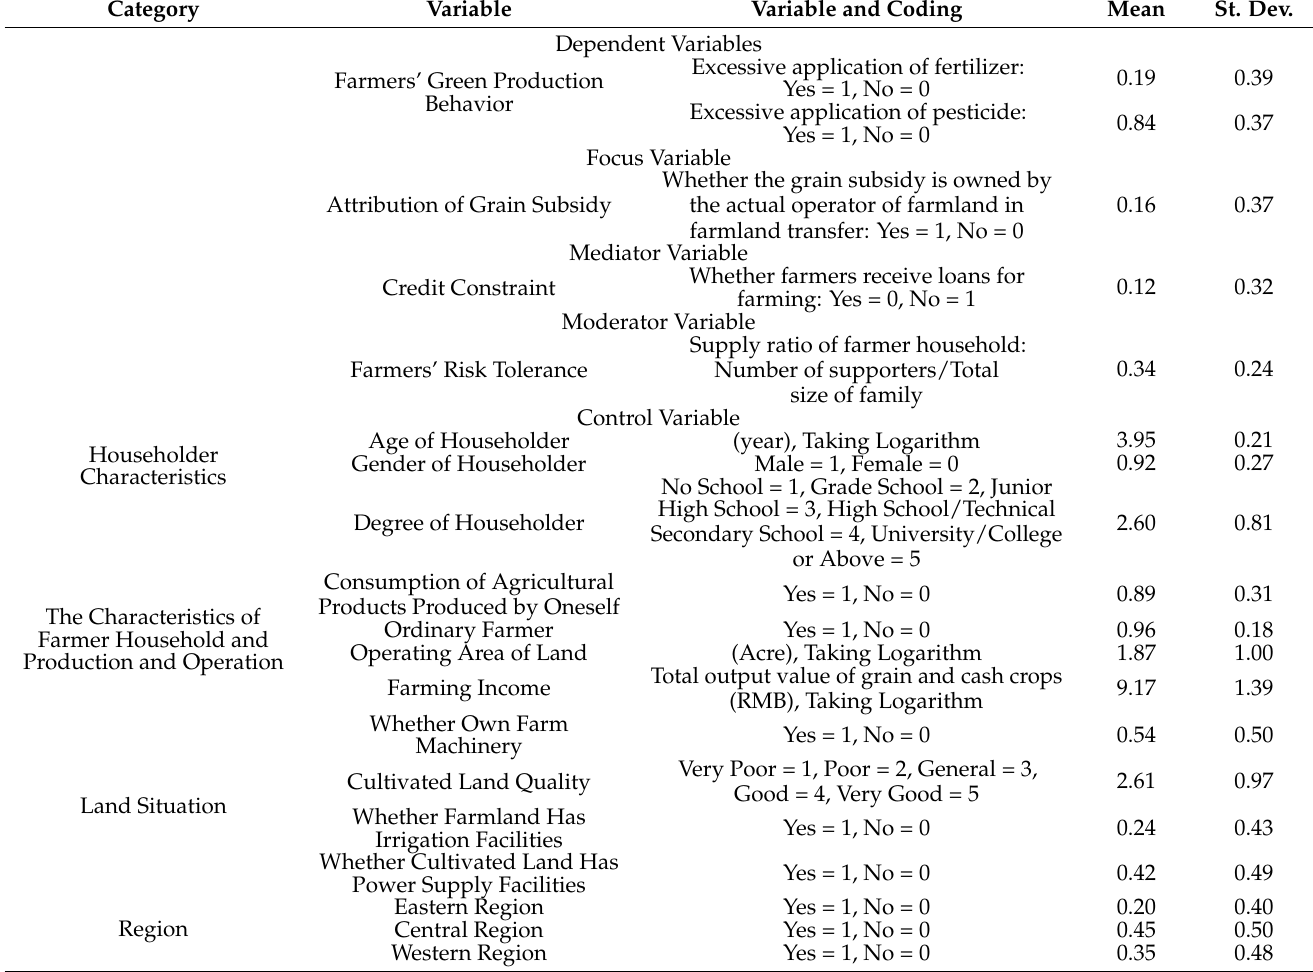
Table 3. Specific Meanings of Variables and Descriptive